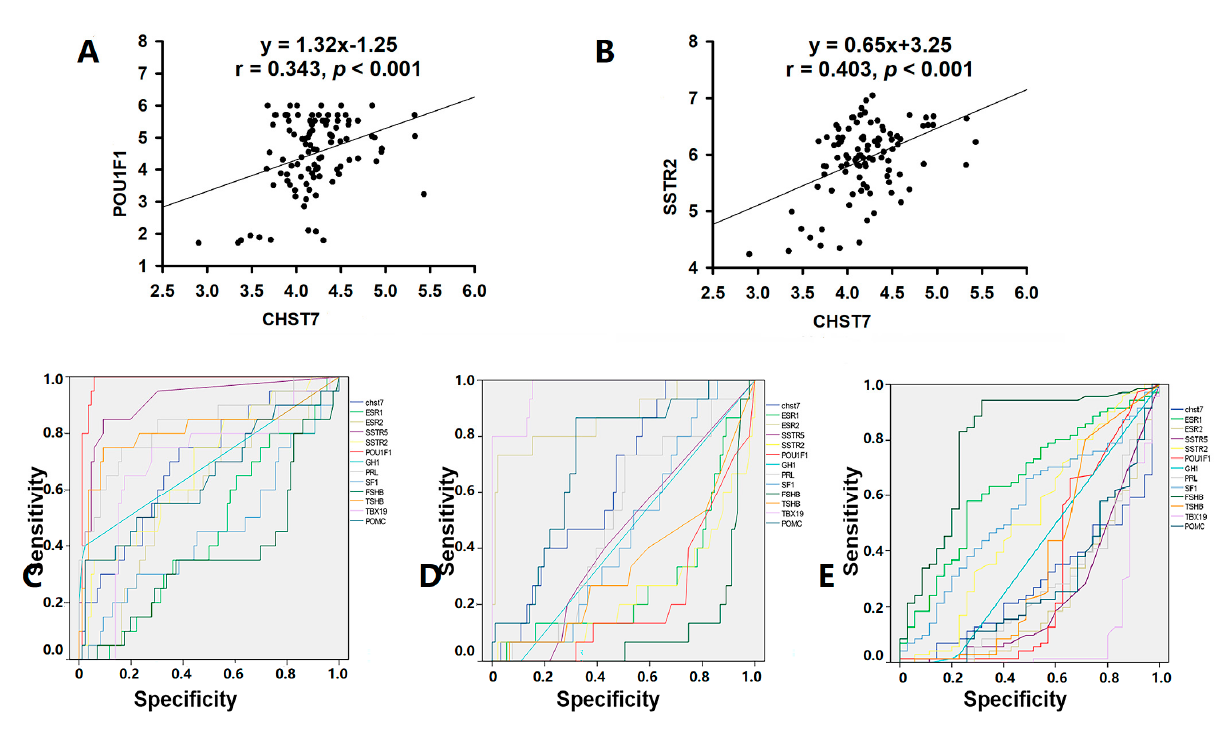
Figure 6. CHST7 is related to the tumor differentiation of PAs. ( A ) Correlation analysis of CHST7 and Pit-1 in 106 samples. ( B ) Correlation analysis of CHST7 and SSTR2 in 106 samples. ( C ) ROC curve of CHST7 for the Pit-1 lineage. ( D ) ROC curve of CHST7 for the TBX19 lineage. ( E ) ROC curve of CHST7 for the SF-1 lineage.